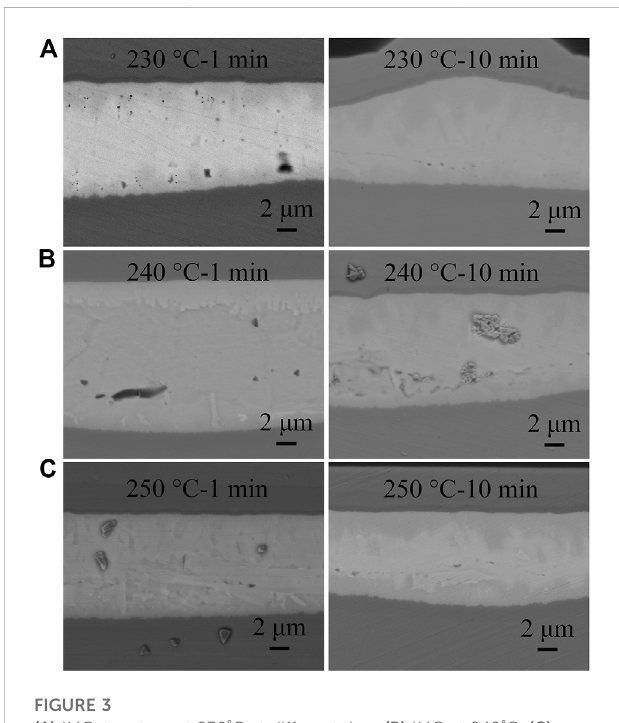
FIGURE 3 (A) IMC structure at 230 ° C at different time (B) IMC at 240 ° C, (C) IMC 250 ° C.